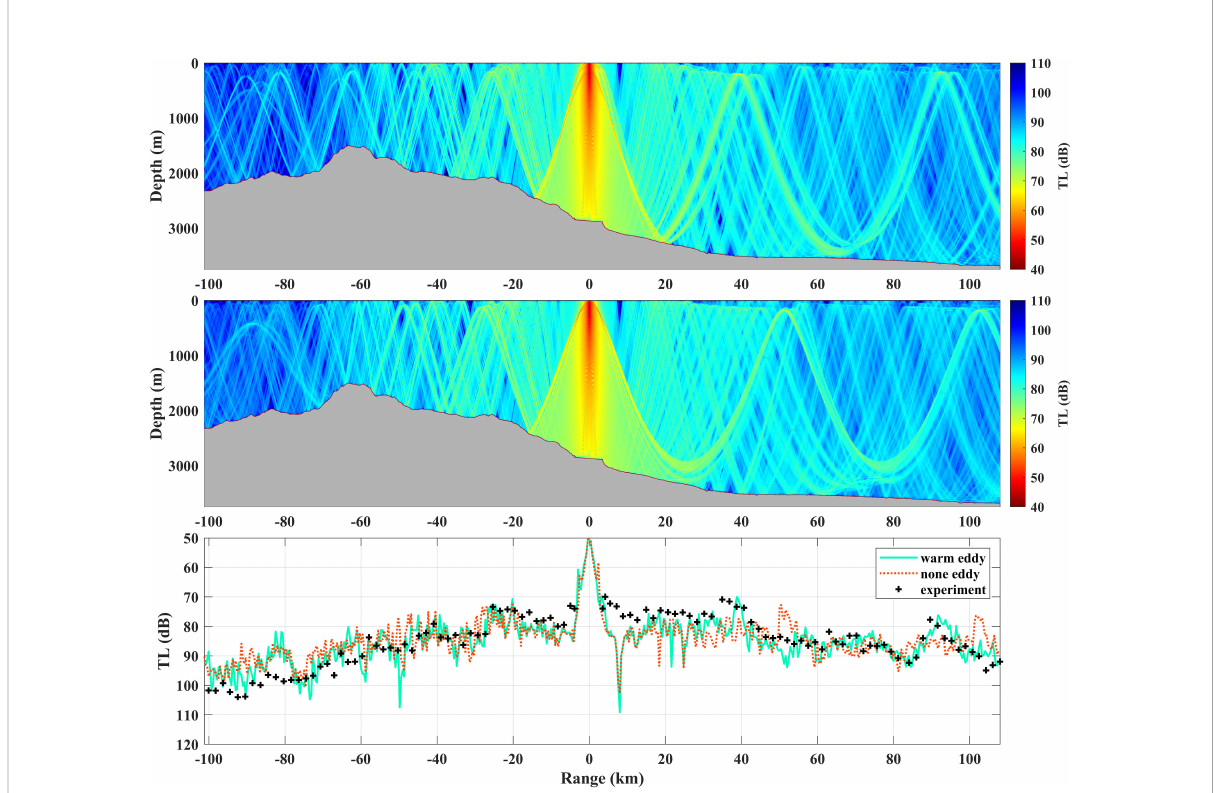
FIGURE 6 The comparison of sound fi eld between the warm eddy and none eddy circumstances. The 2D sound TL in the r-z plane with warm eddy (none eddy) circumstance is shown in the upper (middle) panel, where the source is deployed at 185 m depth and 0 km distance, and the grey shaded area represent the sea bottom. The TL (unit: dB) curves are arranged in the bottom panel with the fi xed RD of 200 m. The green solid line, red dotted line, and black cross symbols indicate the TLs for the simulated warm eddy, simulated none eddy, and in the experiment,